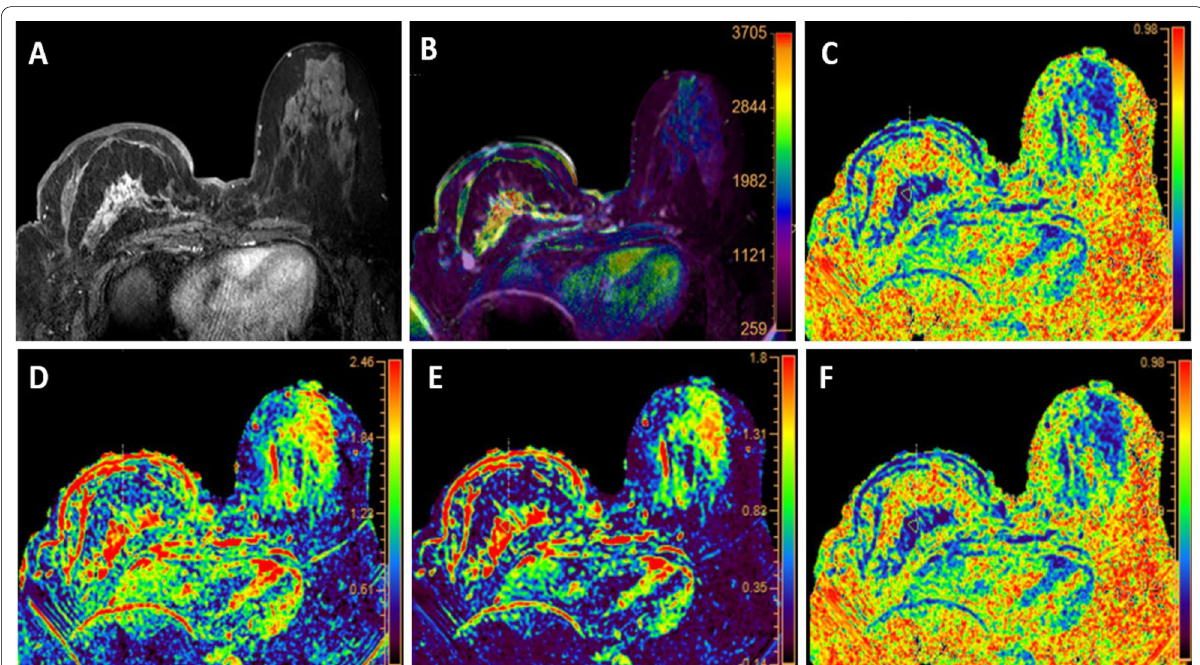
Fig. 1 A 60‑year‑old female with previous right BCT 3 years ago for grade II IDC. A DCE‑MRI shows regional clumped NME in the upper inner quadrant of the right breast. B Fused DCE‑MRI and DTI images used for ROI placement. Parametric color maps of DTI C FA, D AD, E RD, and F RA were generated and analyzed. ROI is placed within the lesion borders to calculate all the DTI parameters. MD AD 1 10 − 3 mm 2 /s, RD 1.2 10 − 3 mm 2 /s, and RA 0.2. The lesion was recurrent grade II IDC on histopathological = × = × =